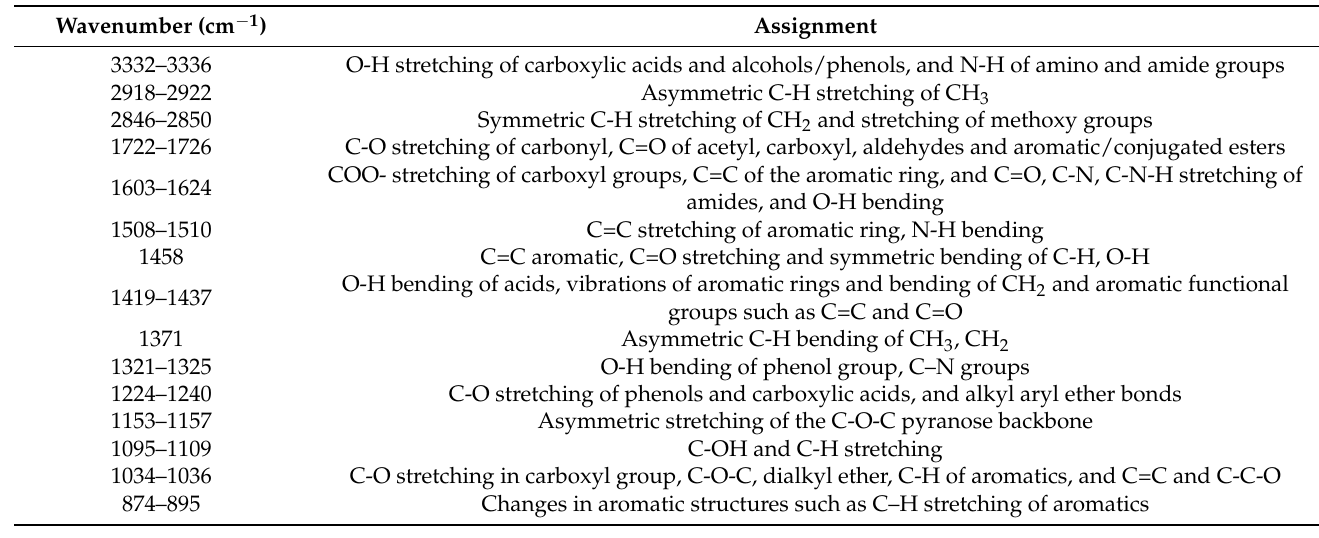
Table 2. Assignment of the main bands obtained by ATR-FTIR for biomass residues.